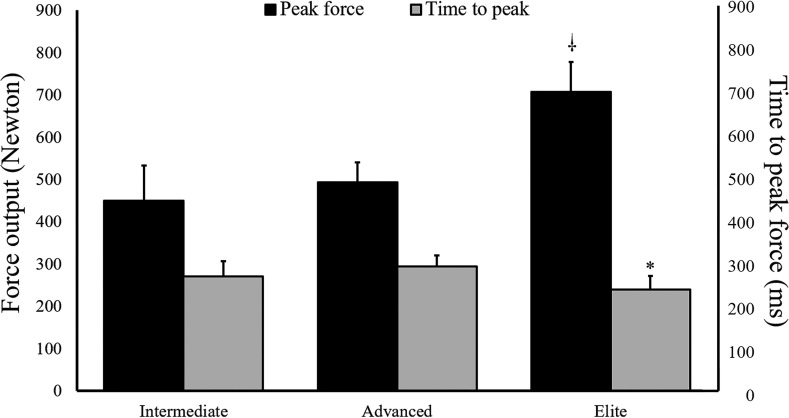
The maximal force output (Newton) and the time to reach peak force (milliseconds) for the three groups.⸸ = significantly higher than the intermediate and advanced groups (P < 0.01). * = significantly lower than the advanced group (P < 0.01).